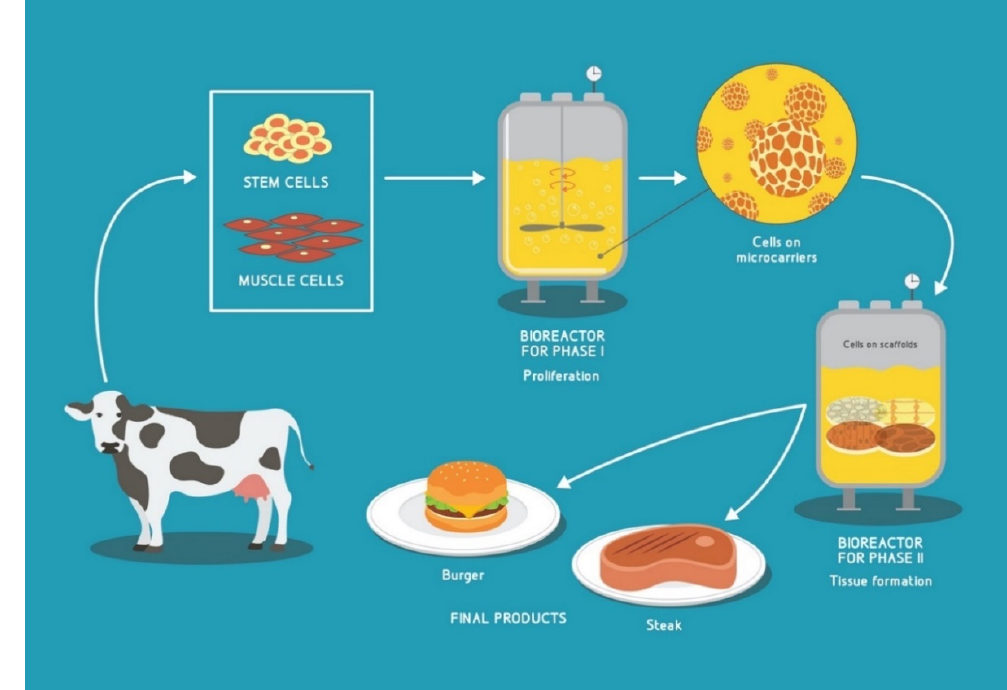
Figure 1. Schematics of cultured meat production.